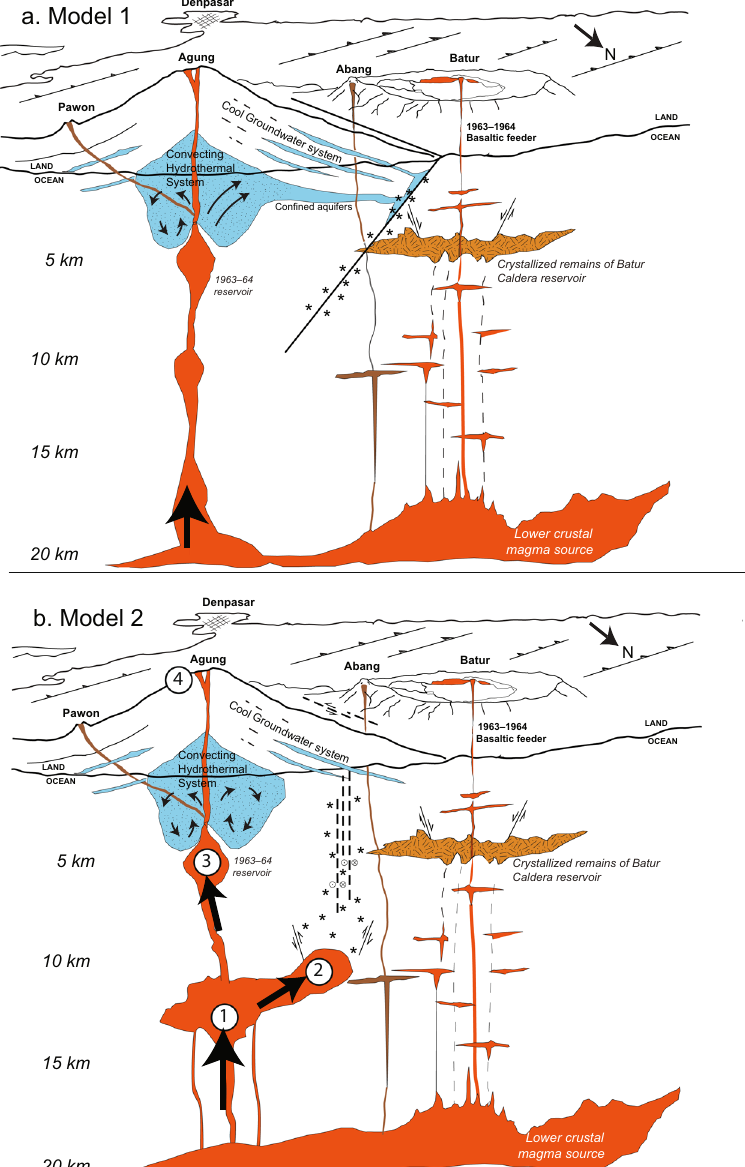
Figure 7. Conceptual cross-sections representing the magmatic plumbing system along a line parallel to the volcanic vents of Pawon, Agung, Abang and the post-caldera Batur cone. The section trends along a 300-degree compass direction and is projected onto a surface cut parallel to the north coast of Bali island. Because this direction is parallel to the inferred dike, its extent in this 2D section is not representative of dike width or volume. Surface features are based on a Google Earth perspective version of the digital elevation model of eastern Bali. Thrust faults shown on the surface are hypothetical; they are inferred from the structural model of McCaffrey and Nabelek (1987) 42 . ( A ) Conceptual cross-section created and used for reference during the volcanic crisis of Agung during October 2017 – January 2018, in which we speculated that magma rising beneath Agung volcano pressurized confined aquifers which in turn activated a pre-stressed fault located between Agung volcano and Batur caldera, resulting in volcano-tectonic earthquakes 21 . ( B ) Conceptual cross- section showing our current model of magma ascent beneath Agung. This model includes deep intrusion beneath the Agung edifice and a 300°-trending dike beneath the region between Mount Agung and Batur caldera. Presence of this intrusive dike is based on the interpretation of InSAR data that became available to the CVGHM and USGS response team in February 2018 10 . According to this model, dike intrusion caused uplift as well as the VT earthquake swarms. Fault geometry is inferred based on strike-slip focal mechanisms from earthquake swarms, although some thrust mechanisms along E-W oriented faults were also present. Numbers correspond to stages of magma ascent, as numbered in the discussion